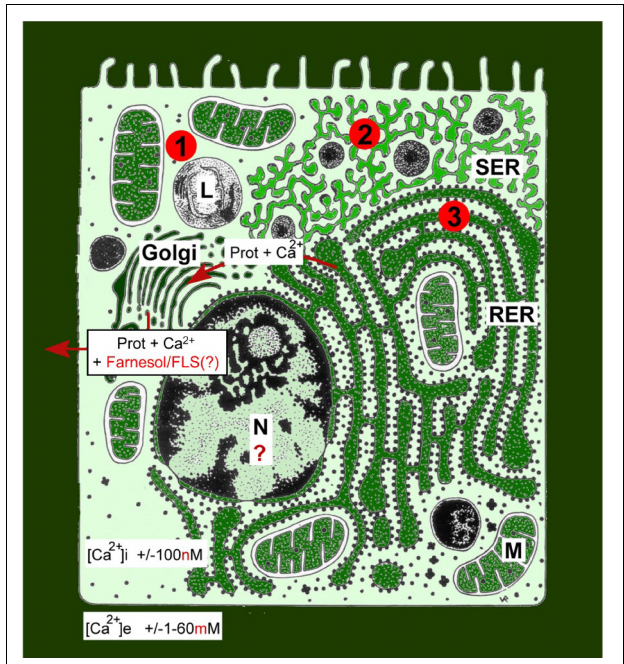
FIGURE 1 | Schematic representation of the Ca 2 + gradients (adapted from De Loof, 2017a). The different shades of green are not meant to give an exact representation of differences in Ca 2 + concentration. L, lysosome; N, nucleus; M, mitochondrion; RER, rough endoplasmic reticulum; SER, smooth endoplasmic reticulum. By just looking at the ultrastructure of cells and by evaluating how abundant the SER and RER are, one can make plausible guesses about the gross outline of their Ca 2 + homeostasis system, as well as of some of its non-genomic effects on those enzyme systems that are involved in lipid, steroid, and protein syntheses. This is due to the fact that numerous enzymes, the activity of which is (partially) controlled by the Ca 2 + gradient over their membrane, are anchored in these SER and RER membrane systems. The red dots with 1, 2, and 3 correspond to the mechanisms 1–3 for keeping [Ca 2 + ]i low (see text). Copyright permission: Own work (De Loof, 2017a), licensed under Creative Commons